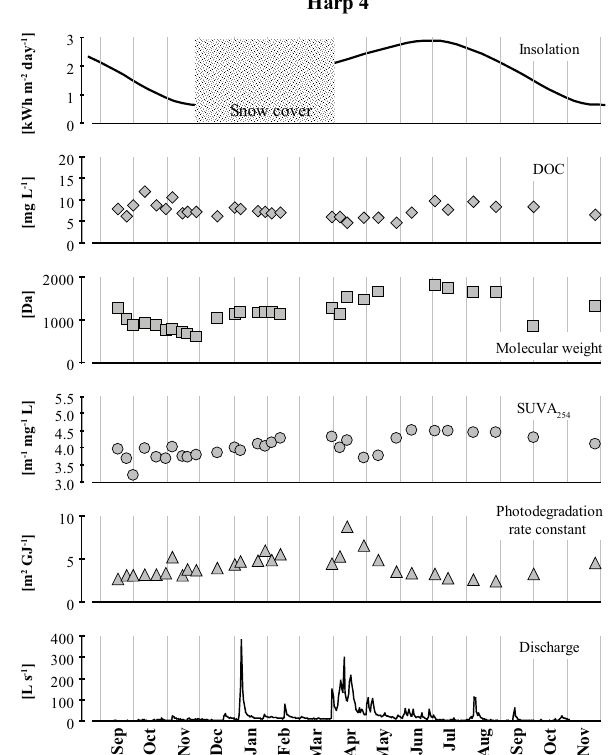
Fig. 3. Plastic 1 (PC1) tributary to Plastic Lake. Average incident in- solation, DOC, apparent molecular weight, SUVA 254 , photodegra- dation rate constant and mean daily discharge during hydrological year 2007–2008.